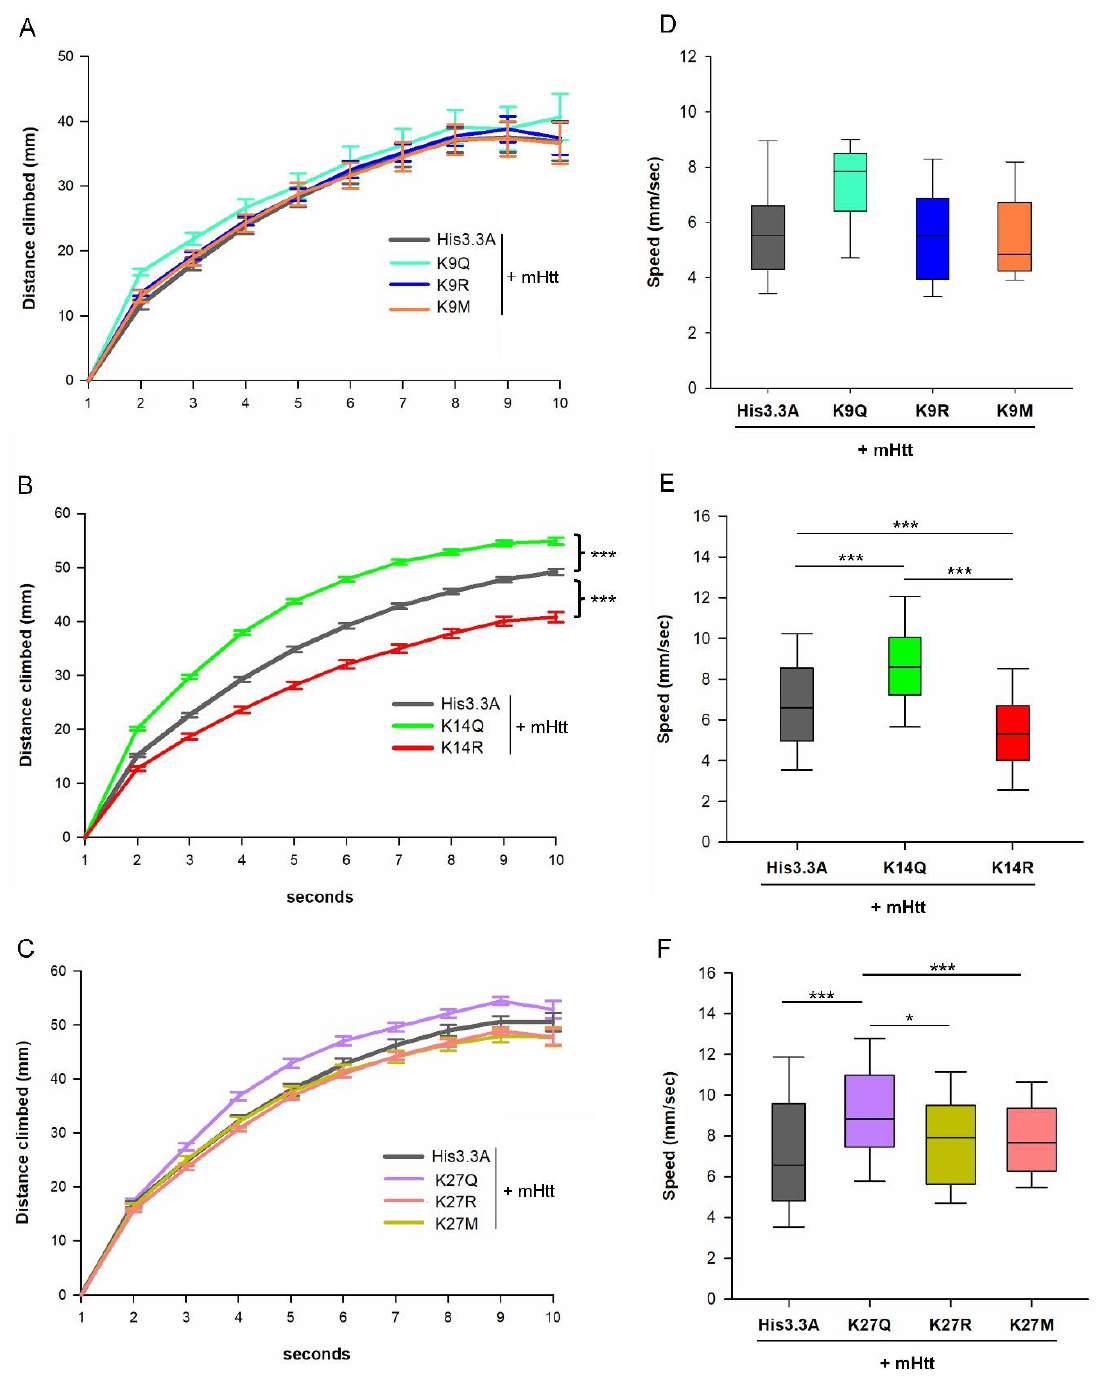
Figure 4. Adult expression of K14Q mutant H3.3 ameliorates , while K14R mutant exacerbates motor phenotypes in HD flies. ( A – C ) Vertical distances climbed during a 10 s time period by male flies co- expressing mHtt + His3.3A-PTM in the adult nervous system under the influence of elav-GAL4 ; tub- GAL80 ts with heterozygous His3.3A KO background. Graphs show the average climbing distance in mm and the error bars represent standard error; a two-way ANOVA was used for the statistical analysis of climbing curves. ( B ) In His3.3A-K14Q -expressing flies, climbing ability improved (geno- type/height interaction p = 3.79 × 10 −1 0 ) compared with the unmodified His3.3A expressing controls, while that of His3.3A-K14R- expressing flies was significantly worse (genotype/height interaction p = 3.33 × 10 −1 6 ). No significant differences were observed in HD flies carrying His3.3A transgenes with mutations affecting the K9 ( A ) or K27 ( C ) residues. ( D – F ) Climbing speed between the 2 nd and 3 rd seconds of male flies co-expressing mHtt + His3.3A-PTM in the adult nervous system under the influence of elav-GAL4 ; tubGAL80 ts with heterozygous His3.3A KO background. ( D ) Point mutations